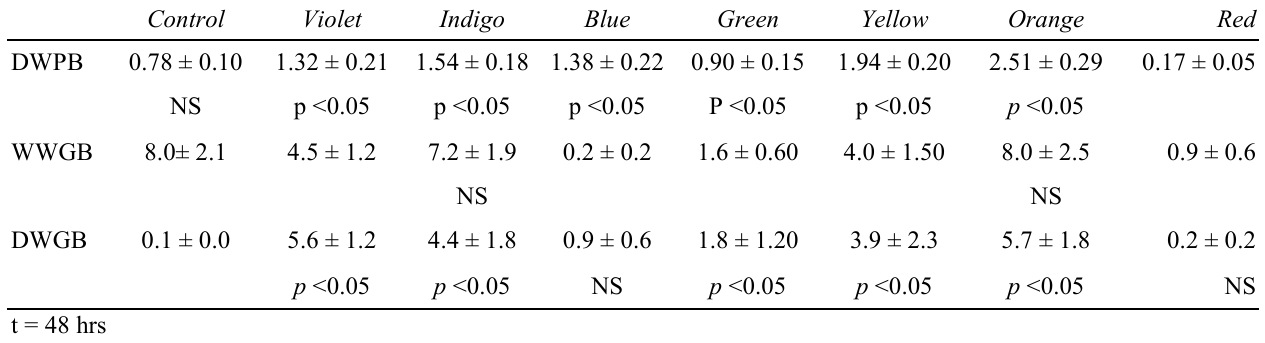
Table 3: Mean ± SD in millimeters of the growth of cotyledons of gram beans following incubation with E-waters at t=48 and 72 hrs. Mean of E-control is compared to other E-waters for enhanced growth by multiple comparison procedure (Turkey test). Three types of water tested were viz; Distilled-water in plastic bottles (DWPB), Well-water in glass bottle (WWGB) and Distilled-water in glass bottle (DWGB). Control Violet